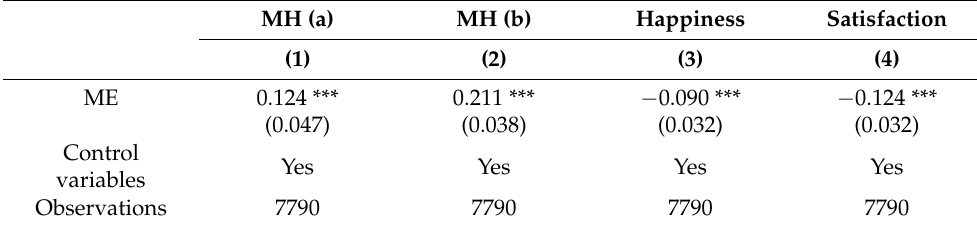
Table 3. Robustness checks: alternative measures of mental